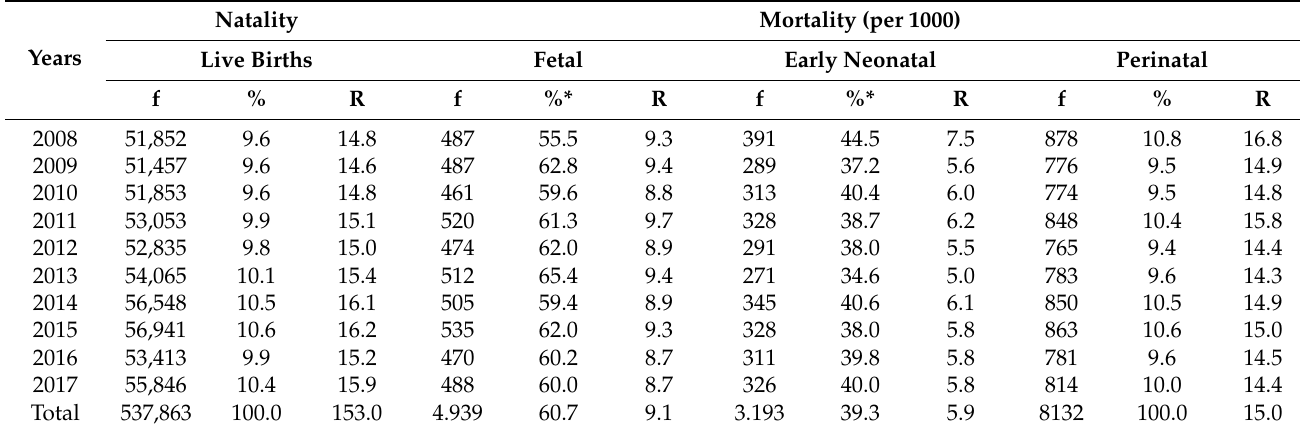
Table 1. Perinatal, fetal, and early neonatal mortality rates, birth rates, and percentage rates. Esp í rito Santo, Brazil, 2008–2017.